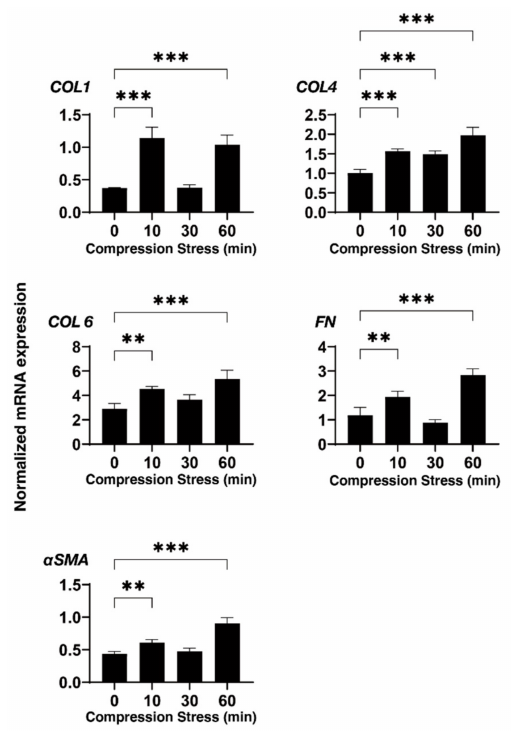
Figure 3. mRNA expression of the ECM proteins of the 3D HTM spheroids after a mechanical compression stress for different time durations. Untreated 3D HTM spheroids were mechanically compressed on day 6 for 10, 30, or 60 min and subjected to a qPCR analysis to estimate the expression of mRNA of the ECM proteins ( COL 1 , COL 4 , COL 6 , FN , and a-SMA ). All the experiments were performed in duplicate using fresh preparations ( n = 4). The data are presented as the arithmetic means ± standard error of the mean (SEM). Note: ** p < 0.01, *** p < 0.005 (ANOVA followed by Tukey’s multiple comparison